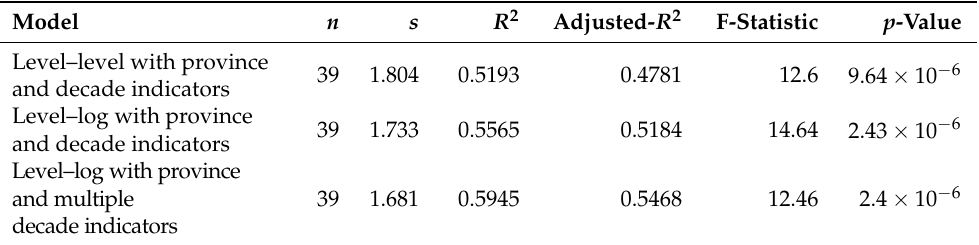
Table 4. Stepwise regression results for modeling hydroelectric power plants.